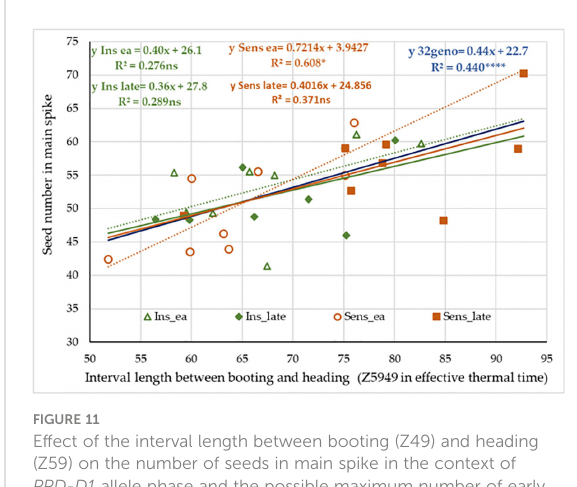
FIGURE 11 Effect of the interval length between booting (Z49) and heading (Z59) on the number of seeds in main spike in the context of PPD-D1 allele phase and the possible maximum number of early – late alleles in the signi fi cant developmental